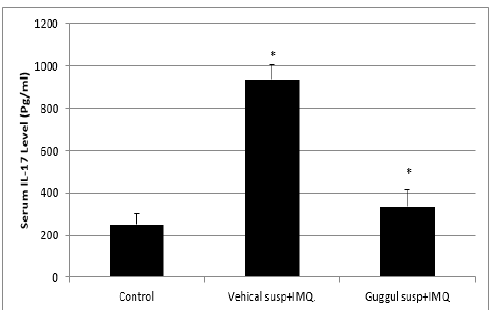
Figure 5. Effect of oral administration of guggulsterone on serum IL-17 level in imiquimod-induced psoriasis in